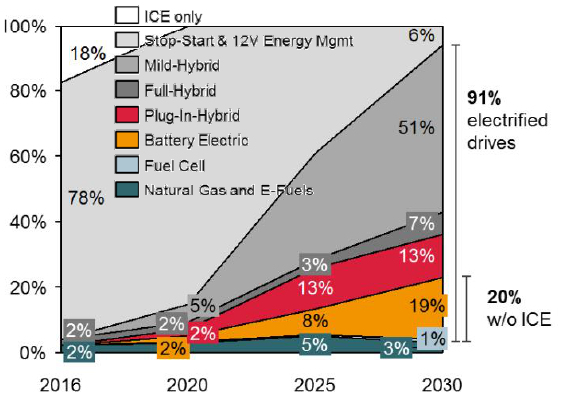
Fig. 1. Market forecast on drivetrain topologies for Europe from 2016 to 2030 (registration of new passenger cars)